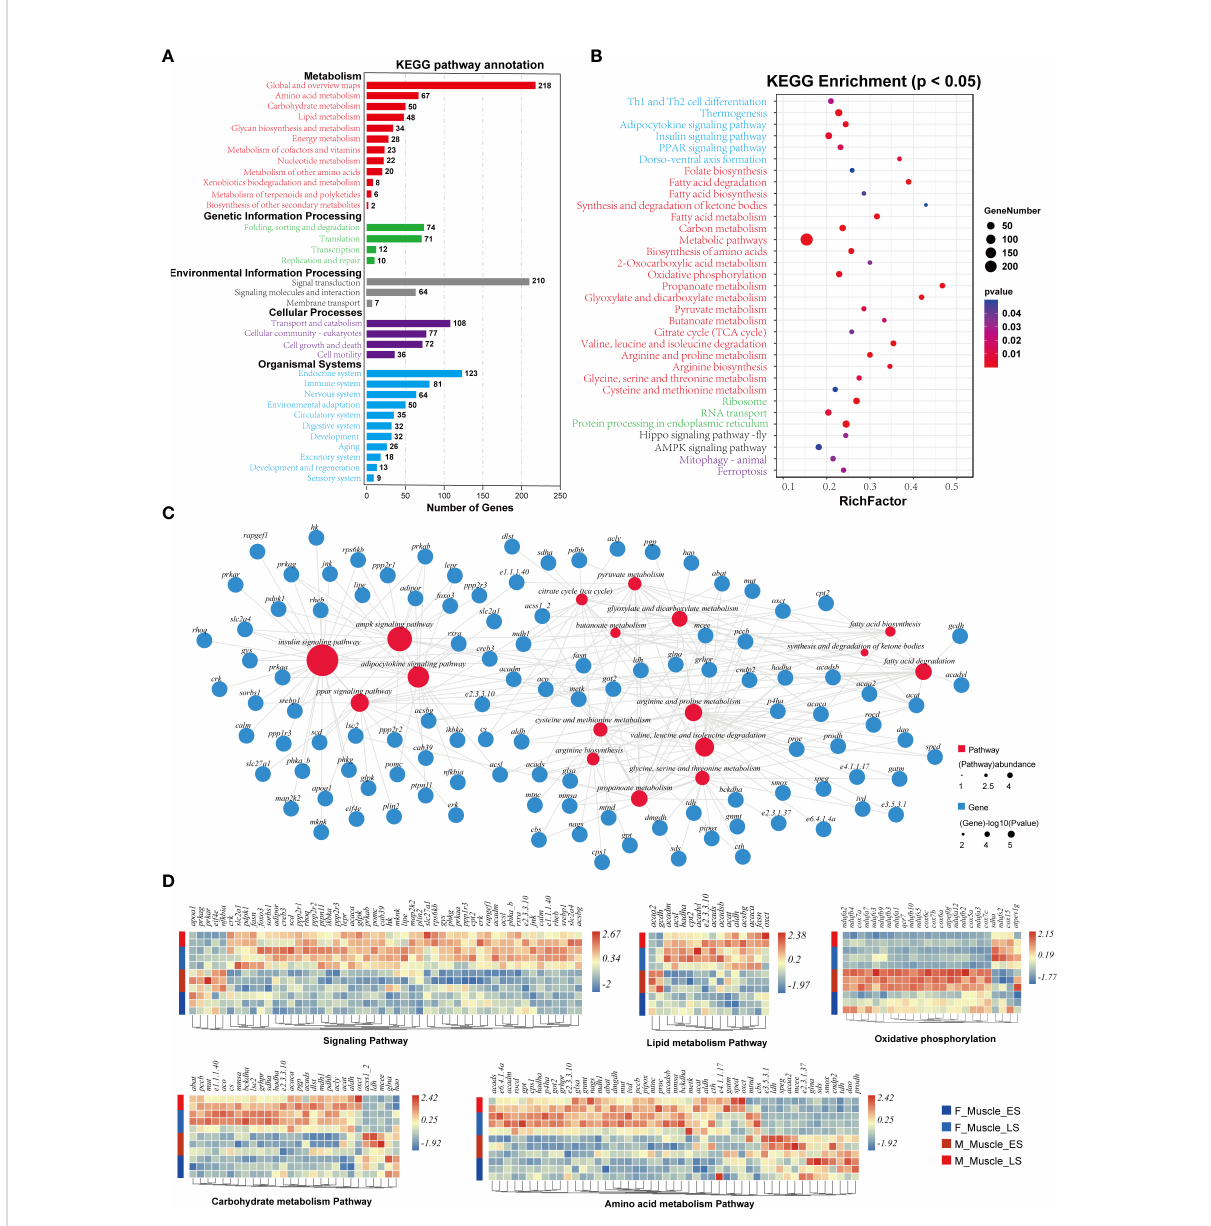
FIGURE 6 The KEGG enrichment analysis of DEGs. (A) All pathways enriched by the DEGs of the muscle in the different sexes at different stages. (B) The signi fi cantly enriched pathways ( p < 0.05). (C) The identical DEGs and pathways participating in the muscle of T. blochii . (D) The gene expression patterns in the main pathways in the muscle of T. blochii